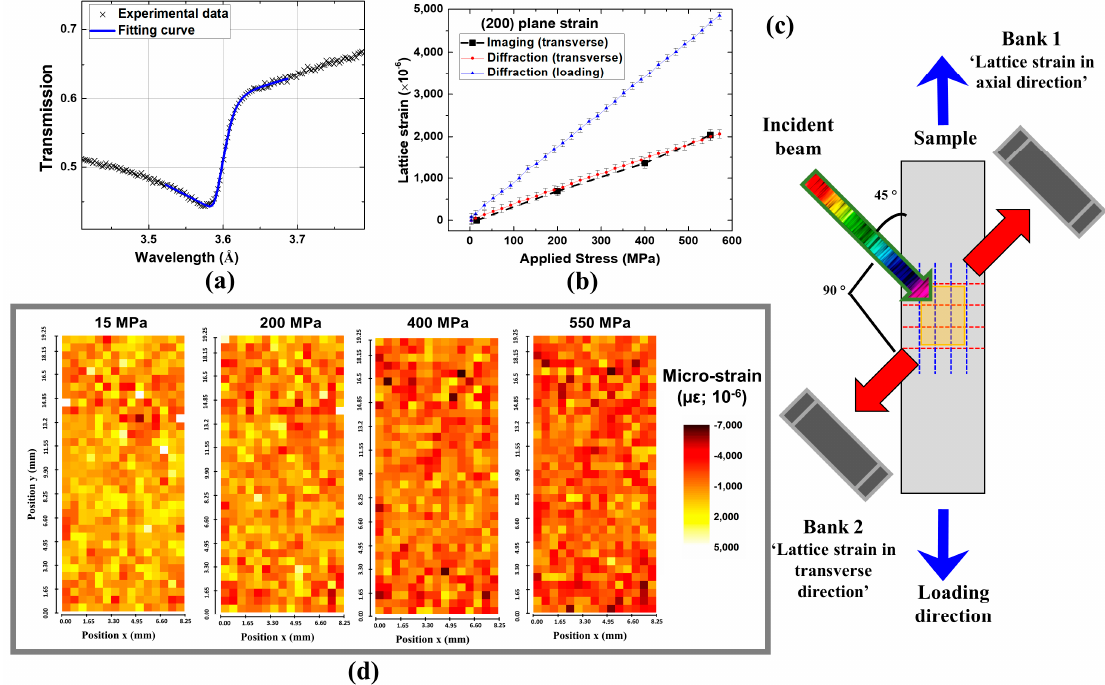
Figure 6. ( a ) iBeatles fitting result of the single Col. Inconel 718 sample. ( b ) Strain evolution during tension loading up to 550 MPa determined by in situ neutron diffraction and iBeatles. ( c ) A schematic illustration of neutron diffraction configuration for in situ tension loading measurements at VULCAN. ( d ) Strain mapping of the (200) Bragg edge during in situ loading up to 550 MPa. The unstrained value of λ 0 edge position was determined from the fitting of the unstrained sample in ( a ) (15 MPa). The strain mapping was conducted over the sample area of 19.25 × 8.25 mm 2 with 10 × 10 binned pixels. The color scale represents strain values in microstrain ( μ ɛ ).